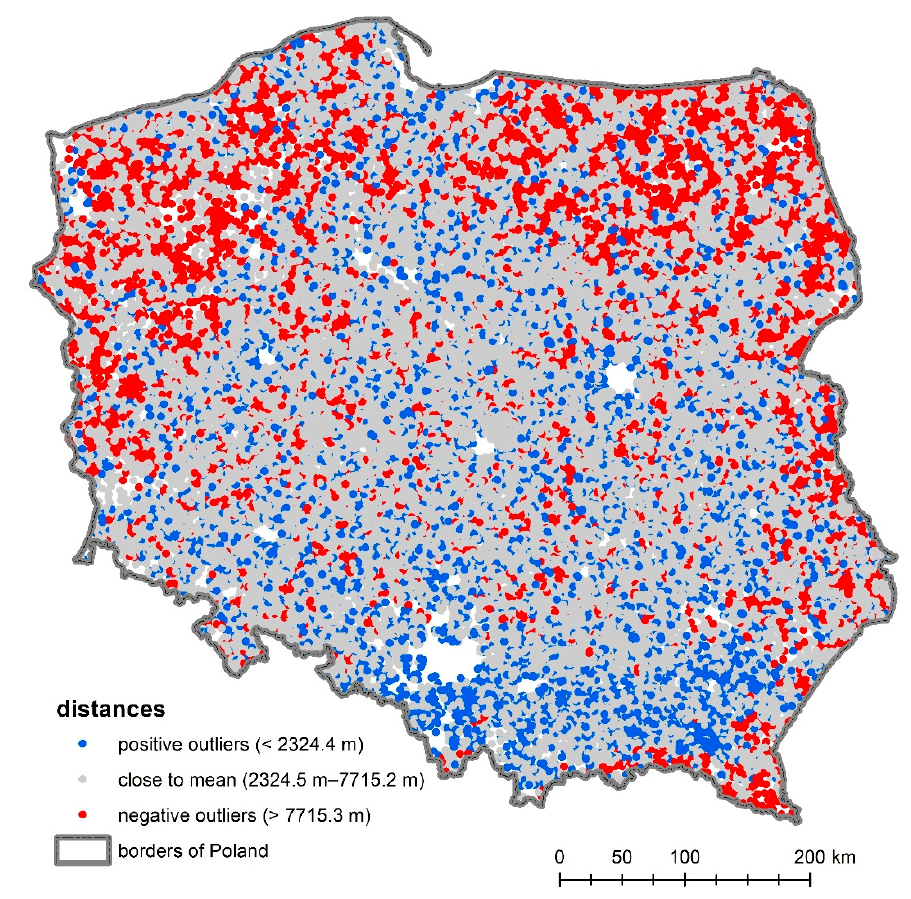
Figure 2. Distances to PHC facilities calculated on the road network.